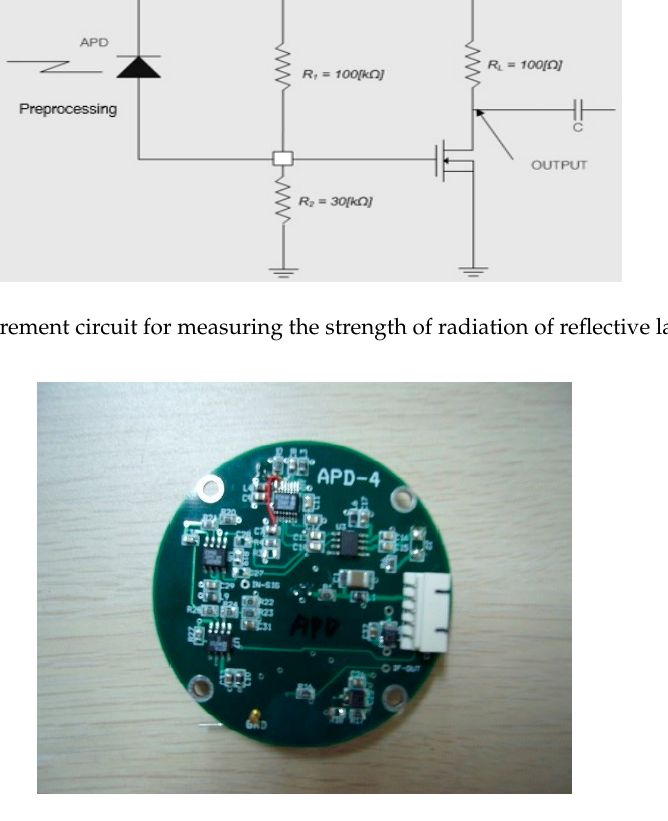
Figure 8. Implemented circuit for measuring the strength of the radiation of the reflective laser beam based on Figure 7.